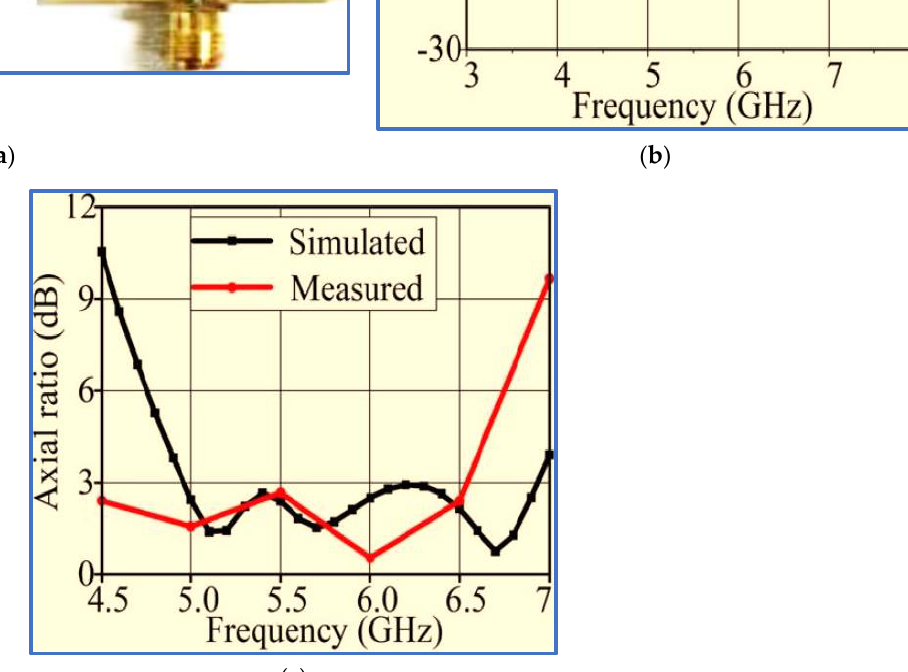
Figure 12. ( a ) Front and back views of a square CP slot antenna. ( b ) Simulated and measured S11 results. ( c ) Simulated and measured AR results [89].